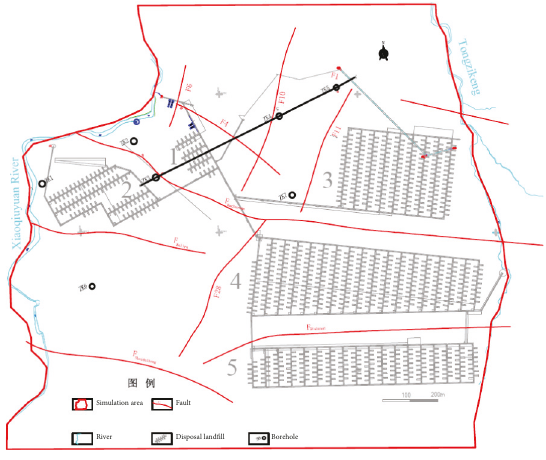
Figure 2: Map of simulation